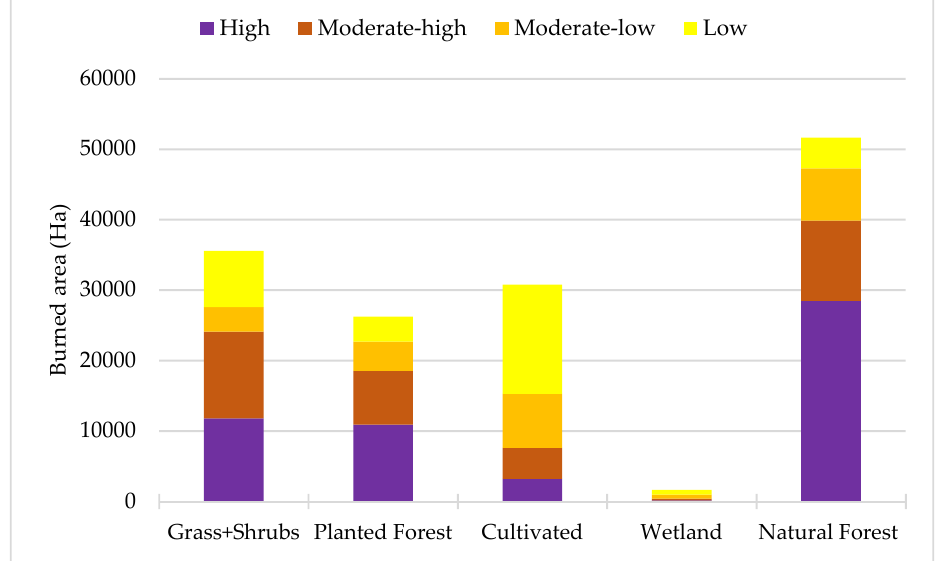
Figure 5. Burned area by land-use/land cover class.